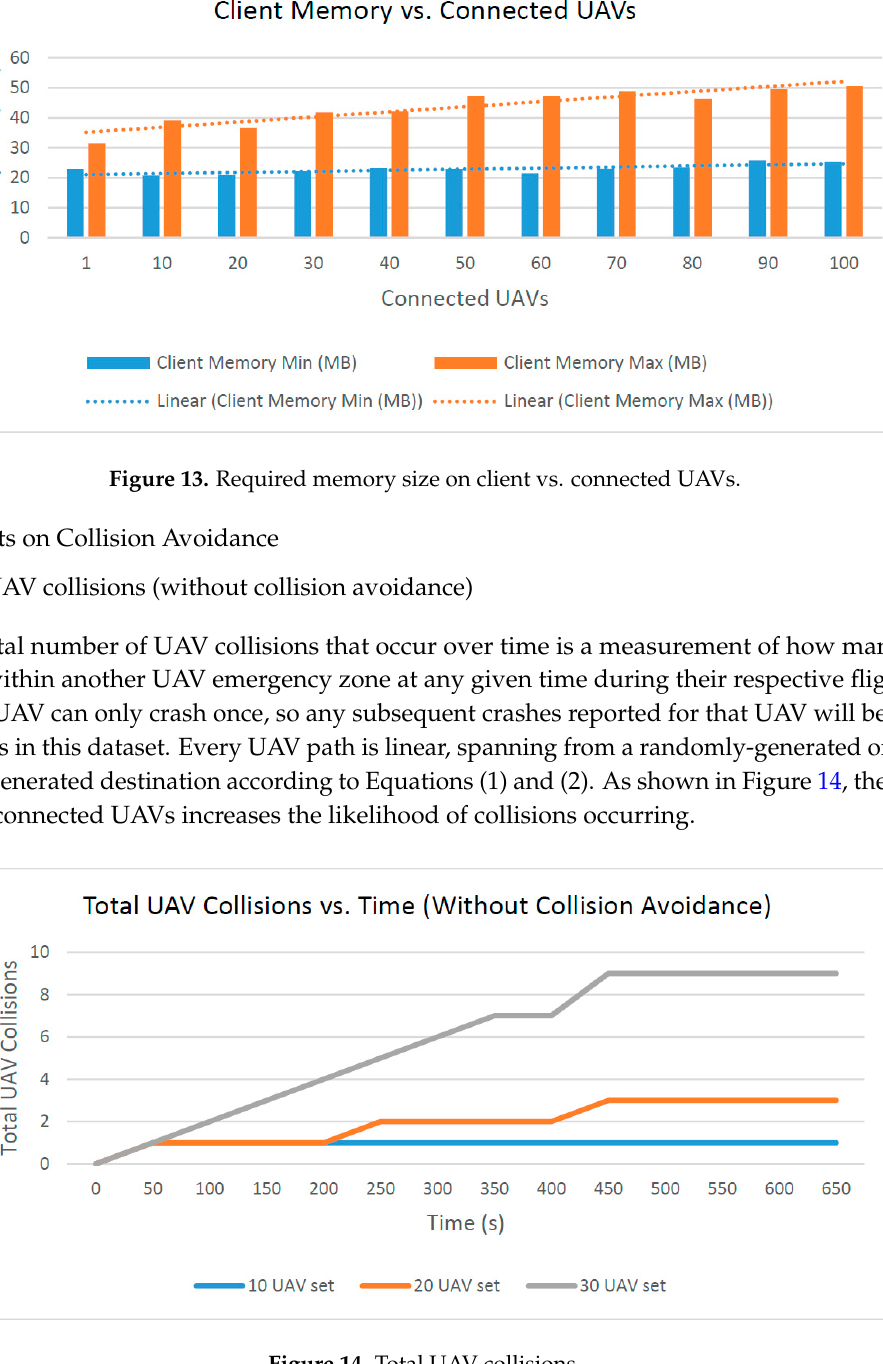
Figure 14. Total UAV collisions.